Question: Write a caption explaining this figure to a reader.
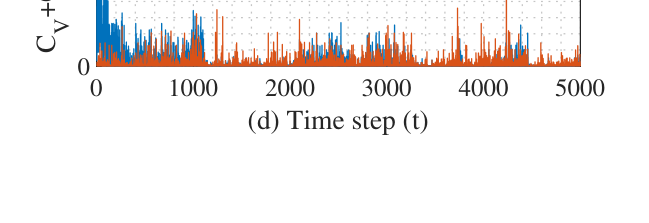
Answer: (a) The input request to node 1. The rest inputs are analogous. (b) The average regret of both methods. (b) The Euclidean distance between two consecutive probability distributions produced by Algorithm 1. (c) Reservation cost (C(At)) for each time slot t. (d) The blocking cost (C0(At, Bt)) .